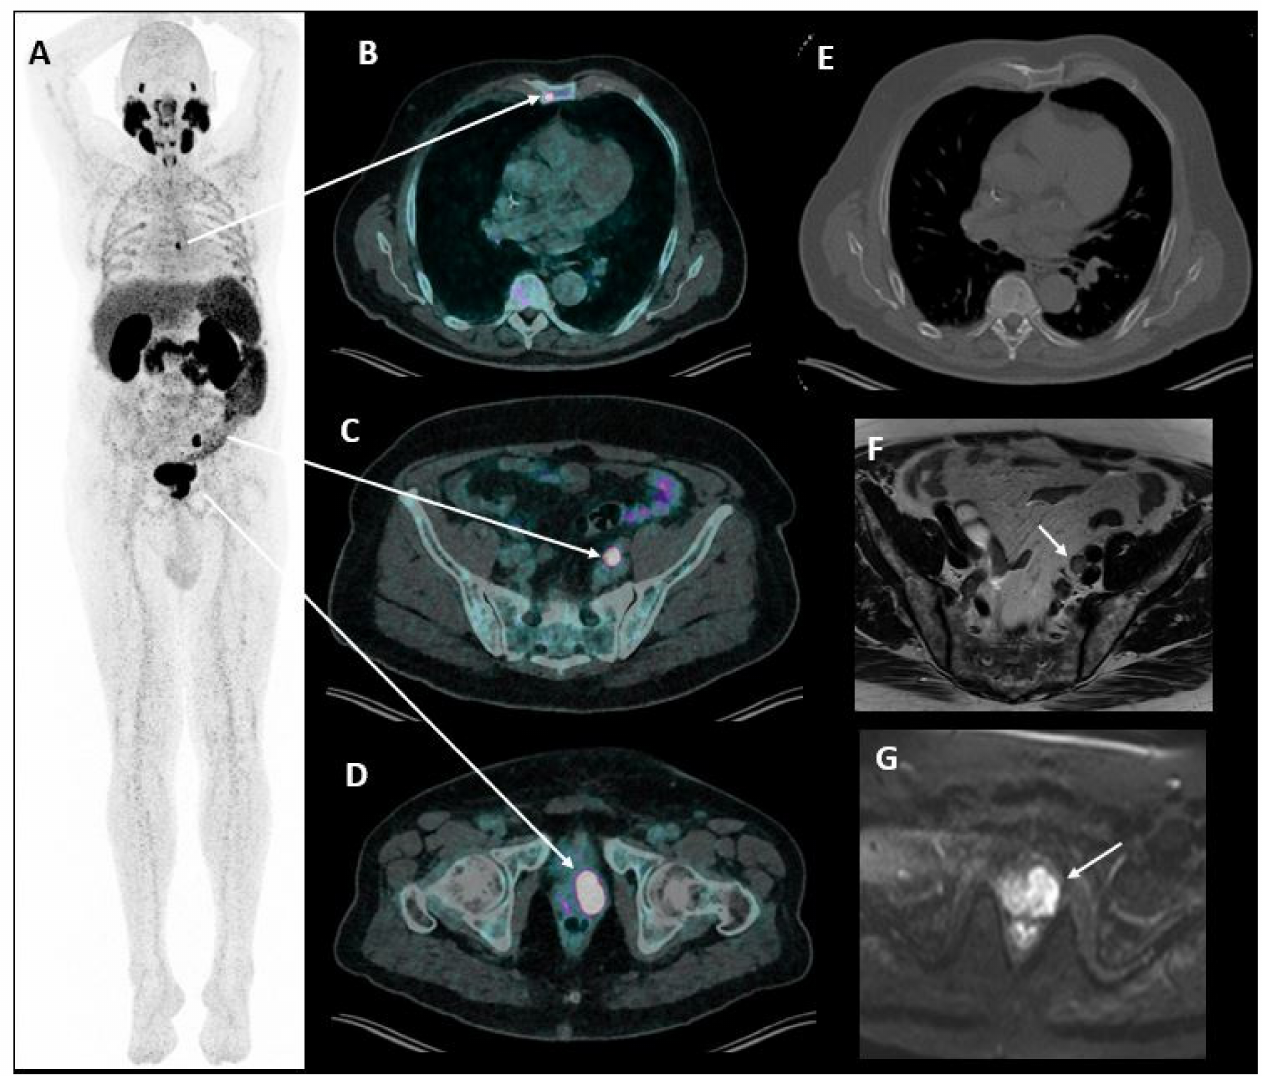
Figure 3. 73-year-old patient with suspected prostate cancer due to PSA rise. PSMA PET/CT ( A – E ) and prostate MRI ( F , G ) evidenced oligometastatic prostate cancer with two metastatic locations including a focal tracer uptake in the sternum ( B ) without correlation on CT ( E ) and one pathologic left external iliac lymph node with focal tracer uptake ( C ) and enlargement seen on T2 weighted imaging ( F ). Note the tracer uptake of the primary tumor on the left prostatic lobe ( D ) with corresponding restricted diffusion on high b-value ( G